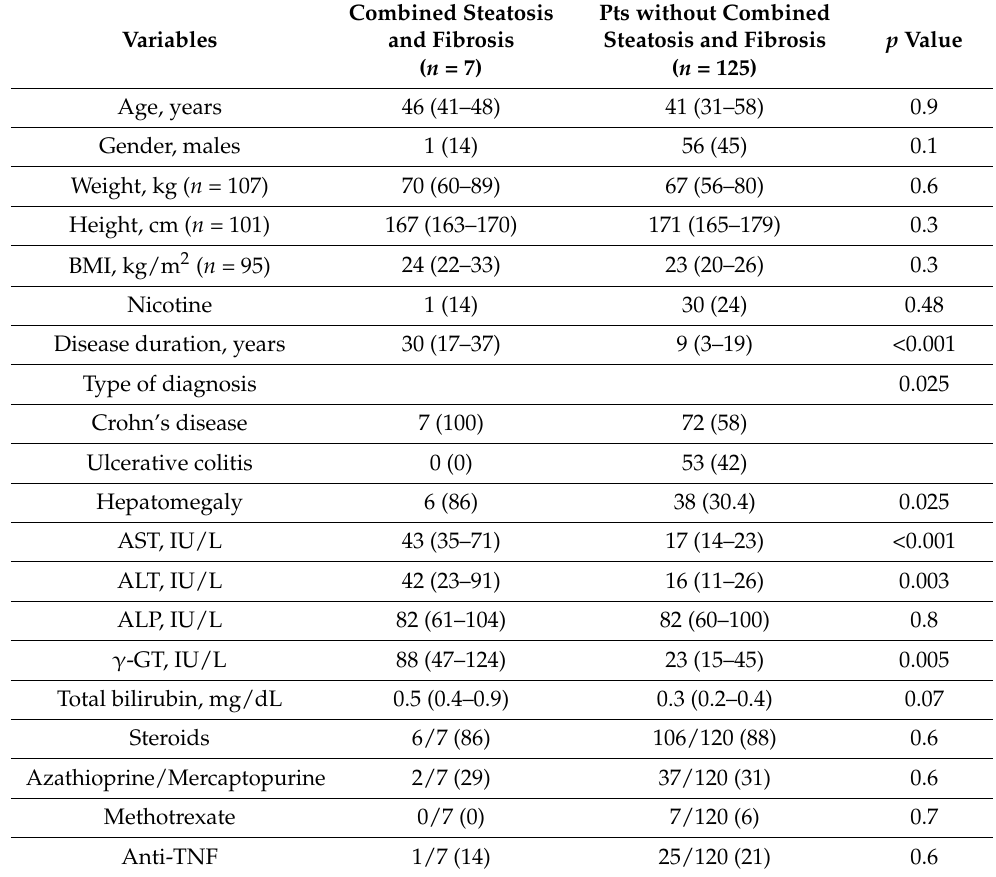
Table 3. Characteristics of patients according to steatosis and hepatic fibrosis pattern.